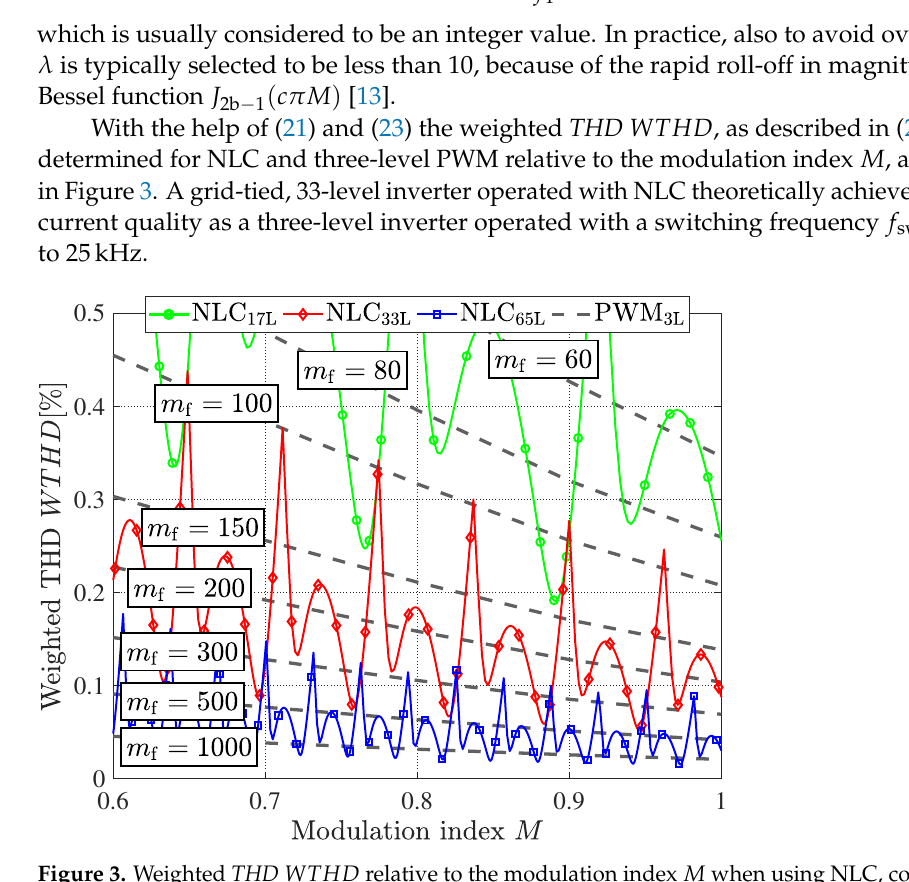
Figure 3. Weighted THD WTHD relative to the modulation index M when using NLC, computed for 17, 33, and 65 output voltage levels, and three-level PWM for different carrier frequency ratios m f